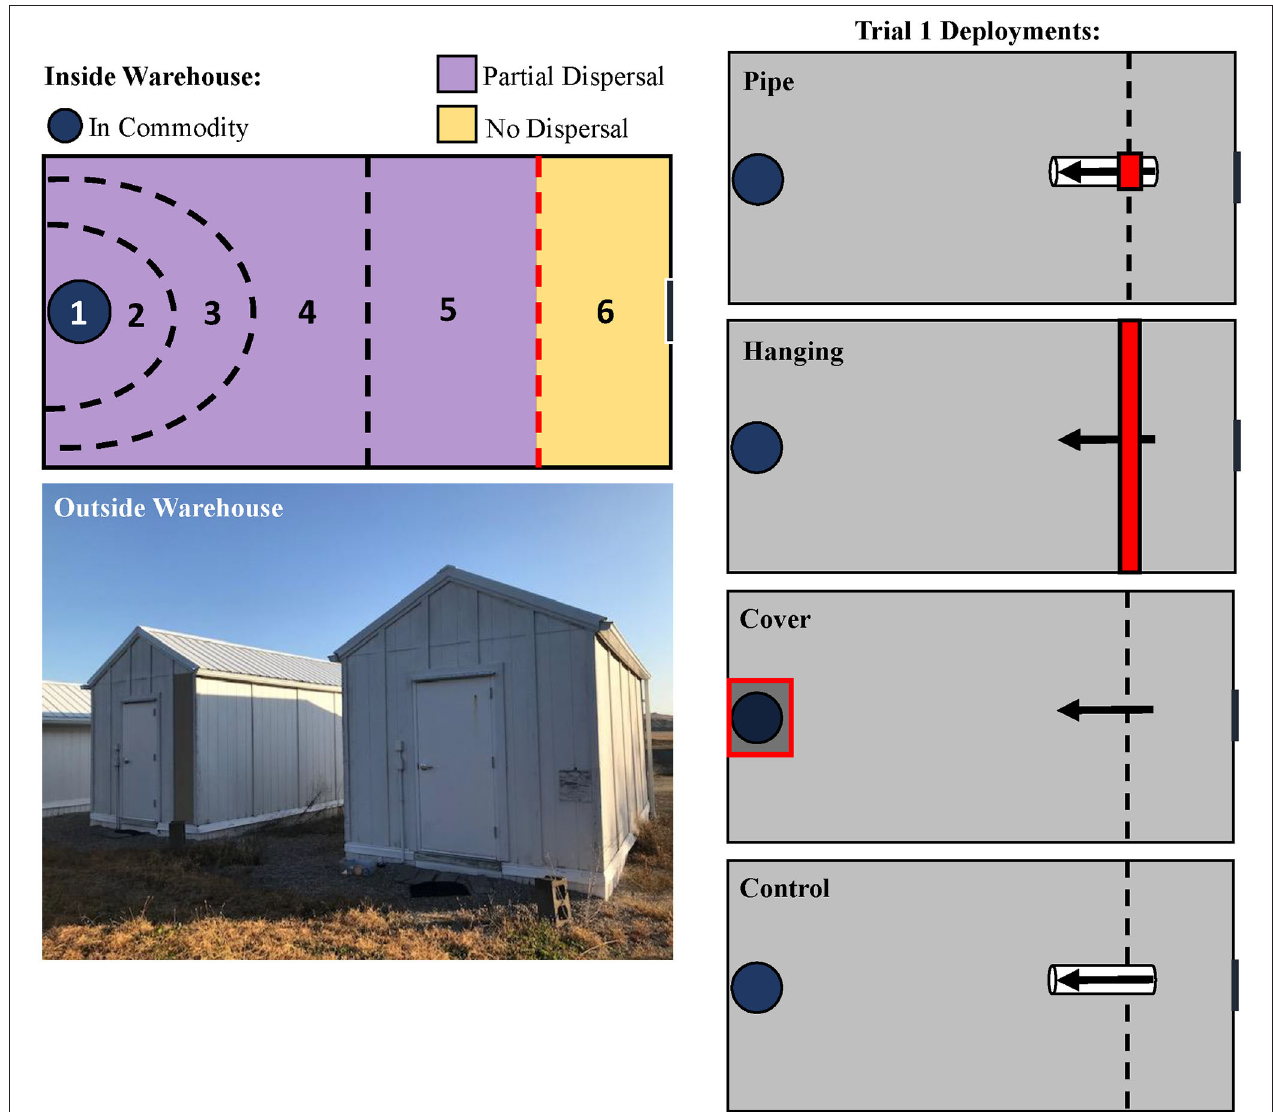
FIGURE 2 | Schematic of the designated recapture zones inside the pilot-scale warehouses where insects were released (top, left) in the LLIN Deployment Assay. Insects were released in Zone 6, given 72-h to travel across the warehouse through Zones 2–5, and collected in the commodity (Zone 1). Outside habitus image of the pilot-scale warehouses used for the LLIN and interception trap deployment assays (bottom, left). Treatments are schematically represented on the right, showing the three LLIN deployment methods for Trial 1, including a control treatment with no LLIN. The red lines indicate deployment of